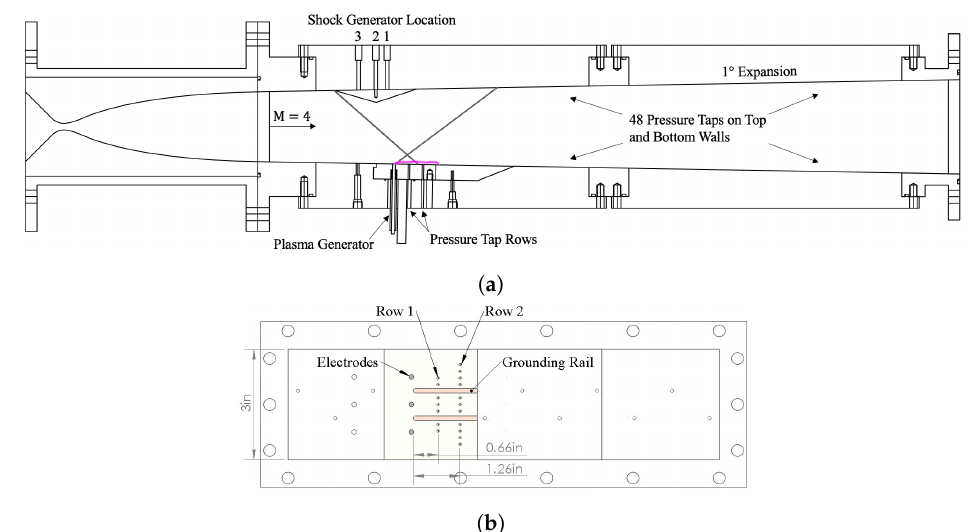
Figure 2. SBR-50 facility test arrangement: ( a ) side view cross-section; ( b ) schematics of the bottom